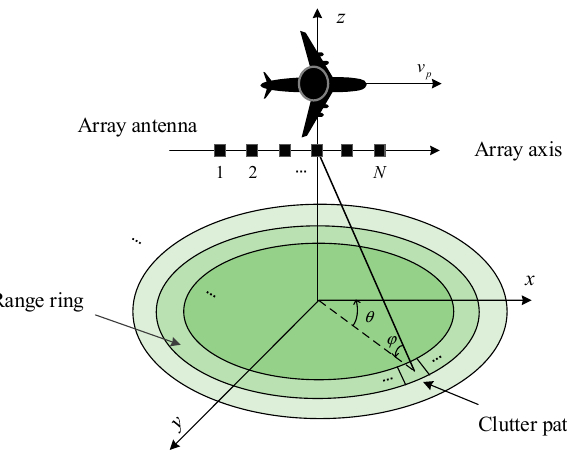
Figure 1. Geometric configuration of an airborne surveillance radar system.